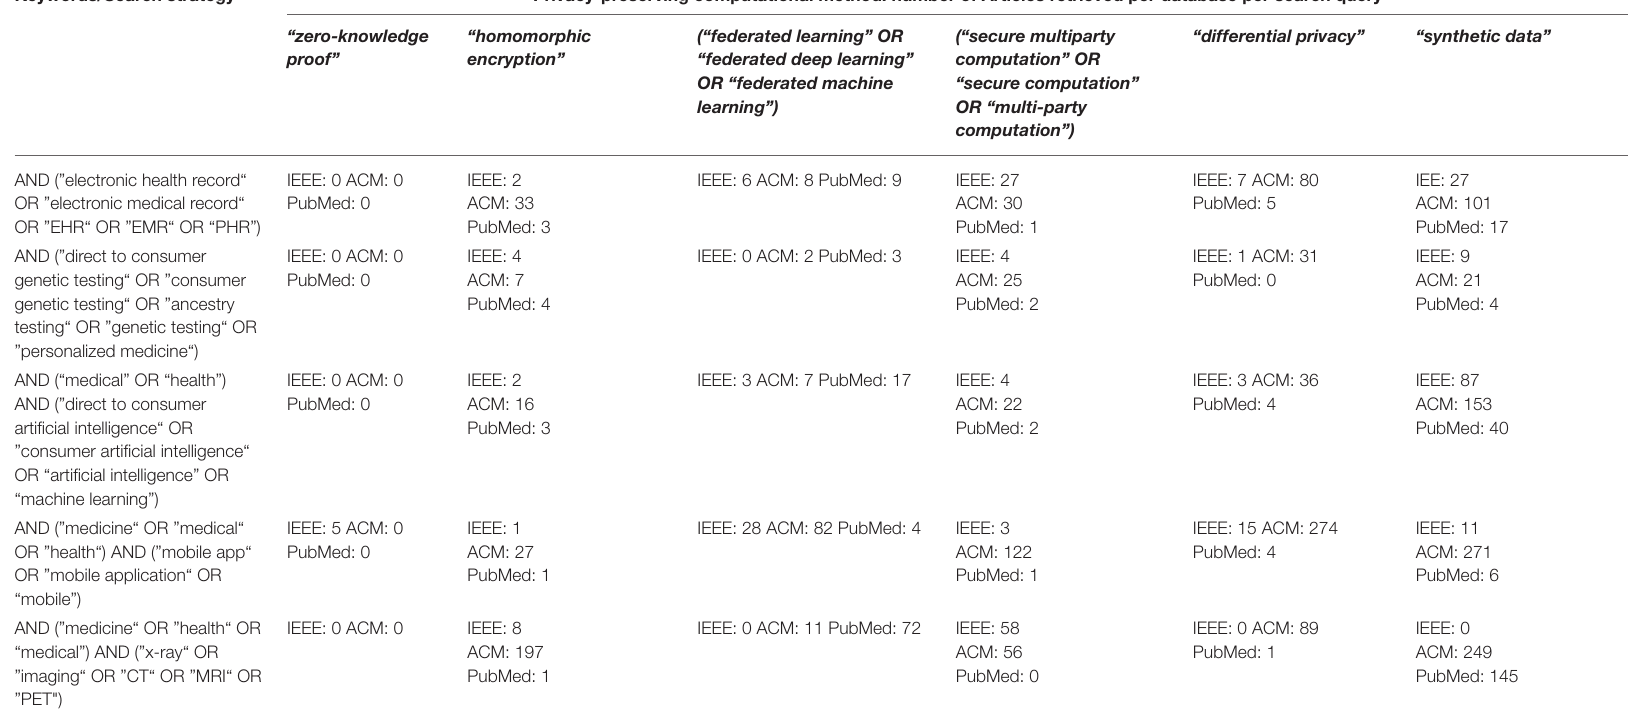
TABLE 1 | A survey of the peer-reviewed literature on use of PETs for healthcare data. Keywords/Search strategy Privacy-preserving computational method: number of Articles retrieved per database per search query “zero-knowledge